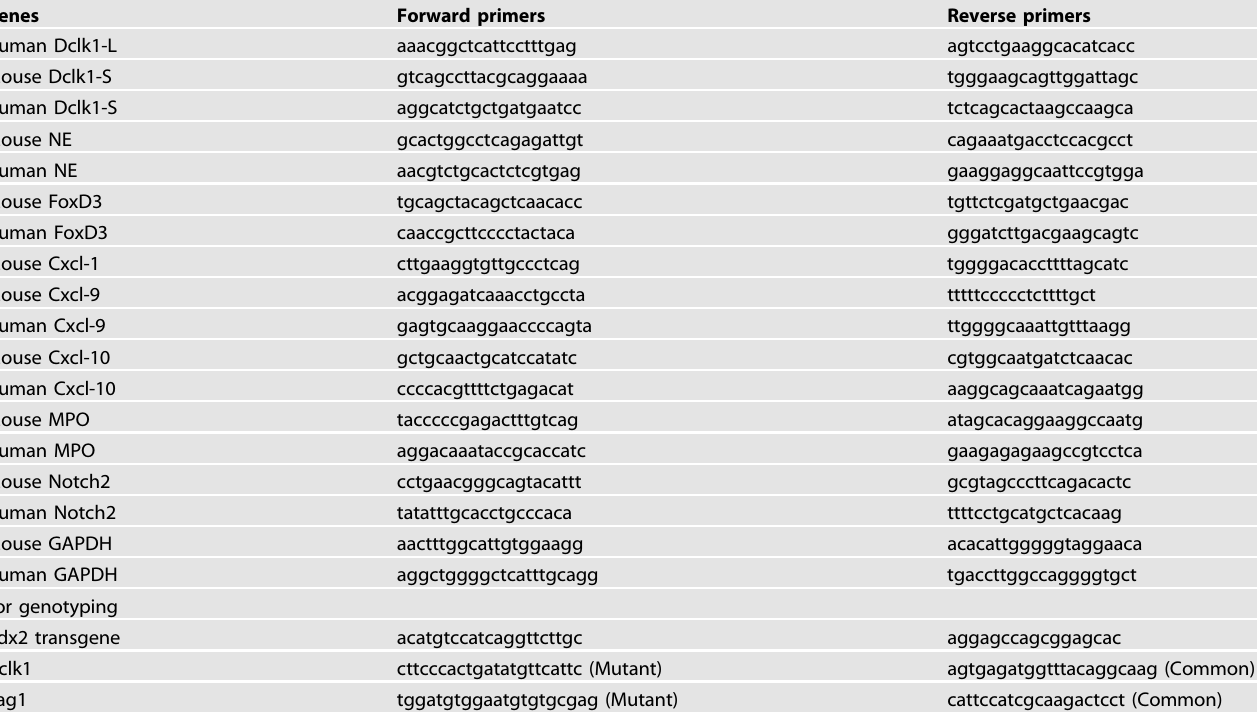
Table 1. List of primers used in the